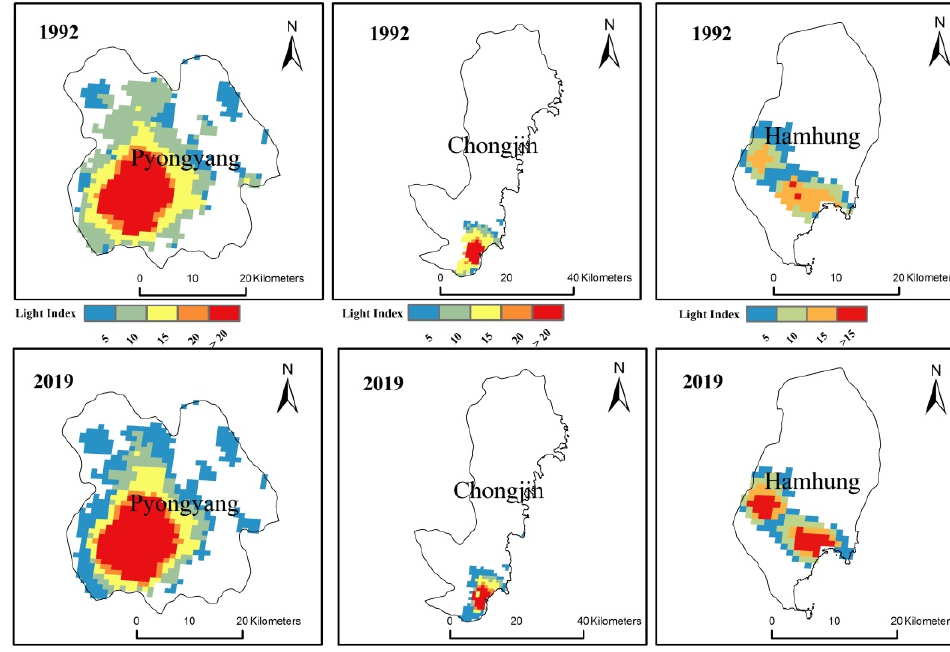
Figure 6. Spatial pattern of dynamic expansion of typical cities in DPRK. Table 3. Statistical results for relevant indicators of light intensity in typical cities in DPRK [km 2 ].